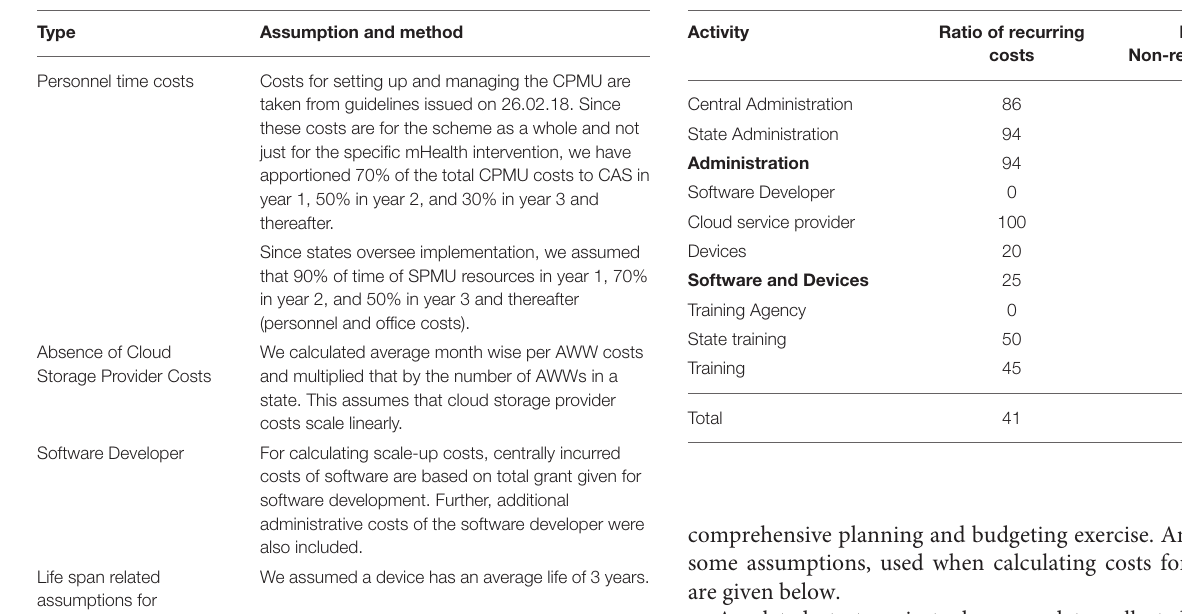
TABLE 1 | An example of assumptions while costing for ICDS-CAS. TABLE 2 | Ratio of Recurring and non-recurring costs across